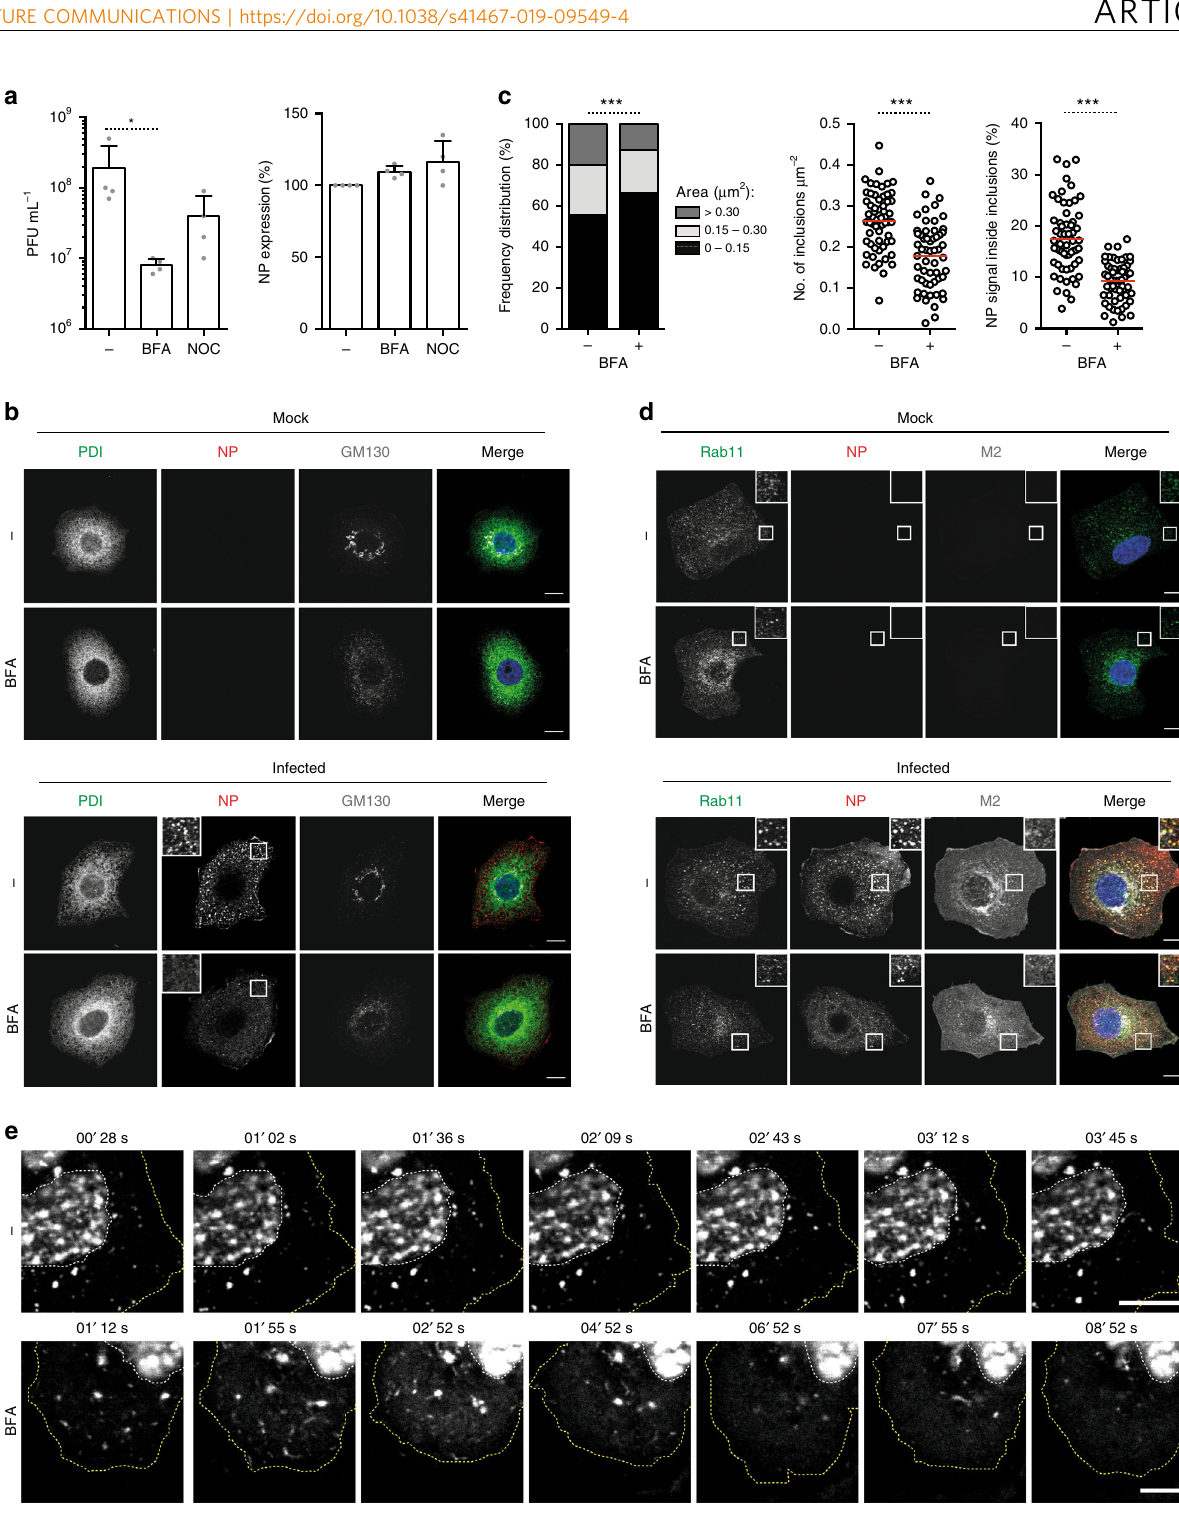
lines for low and high expression of GFP-tagged proteins (Supplementary Fig. 5a) and evaluated viral production. Results showed that cells expressing high and low levels of GFP, or low levels of GFP-Rab11 WT were equally permissive to viral infection at 8, 10, and 16 hpi (Supplementary Fig.